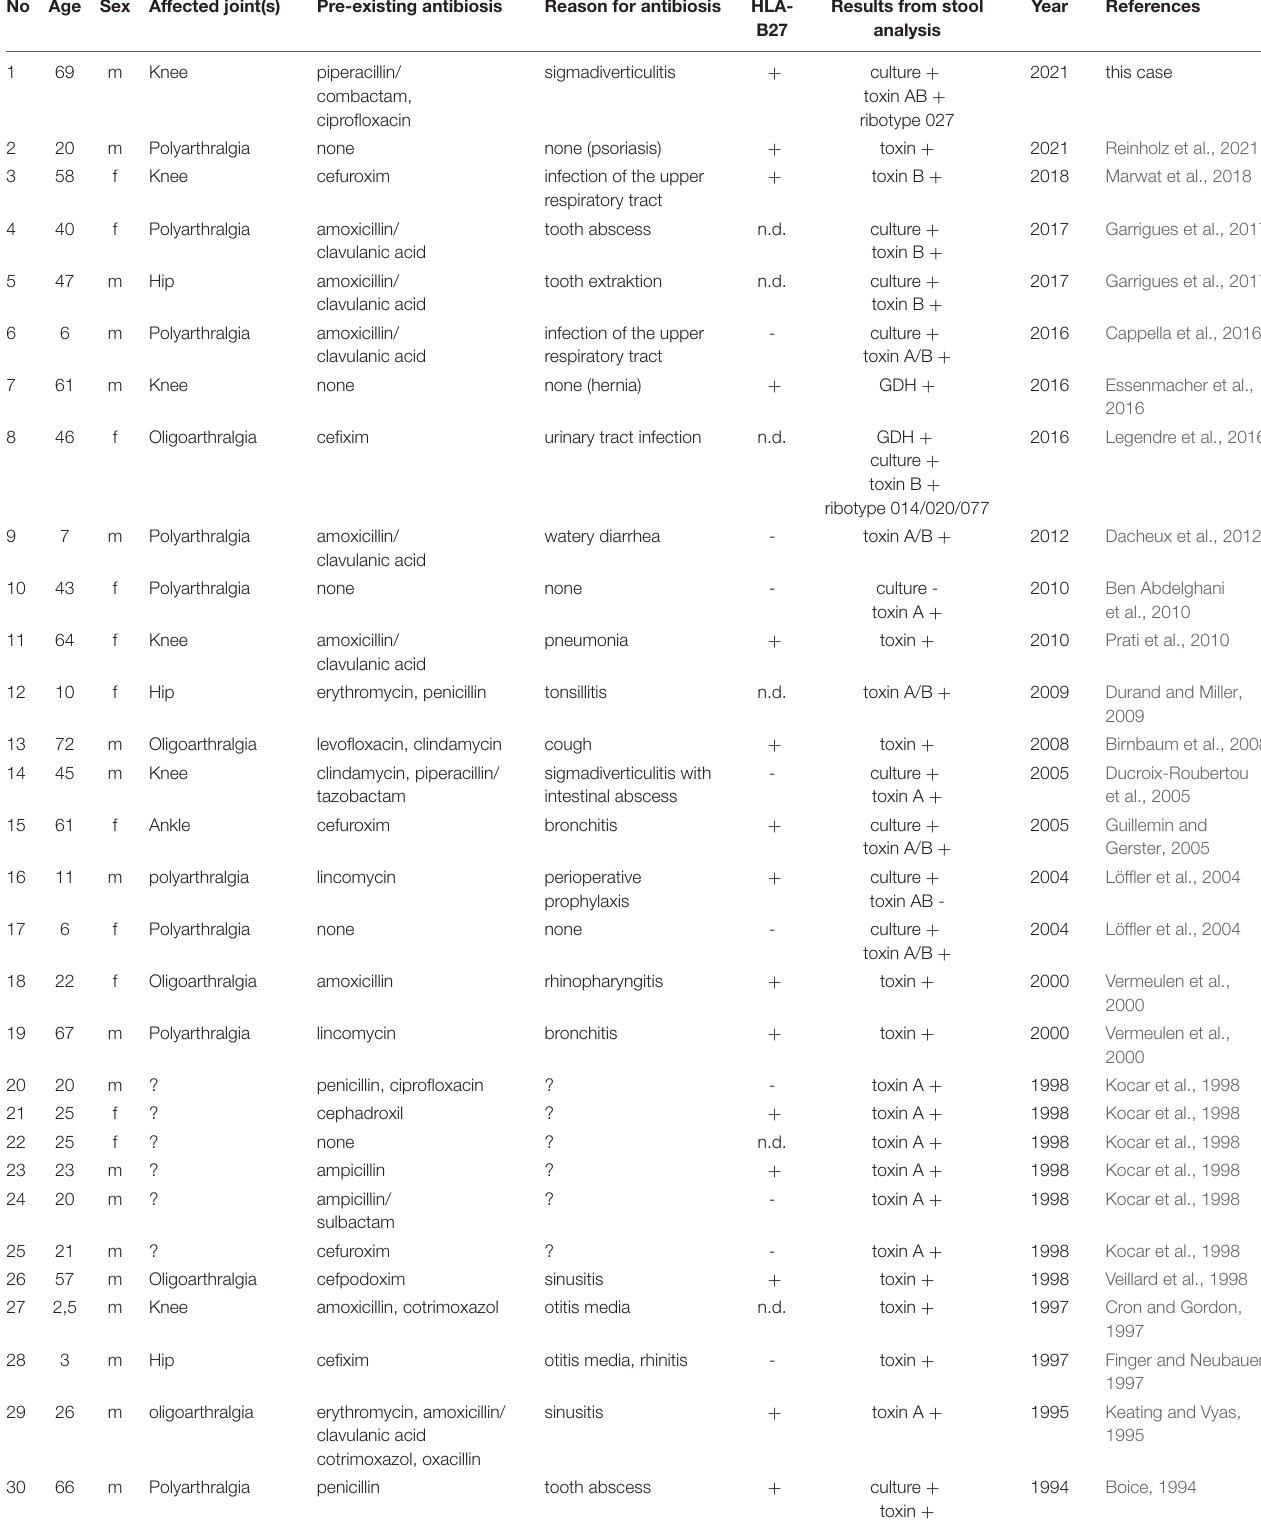
TABLE 1 | Published cases of C. difficile -associated reactive arthritis (CDARA) in chronological order. No Age Sex Affected